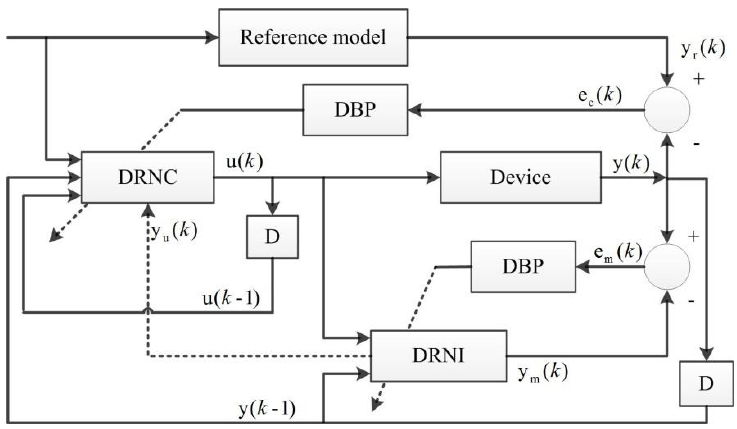
Figure 6. Control system structure based on the DRNN.